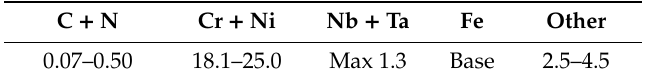
Table 2. Chemical composition of laser cladding material LC3530 (wt%).